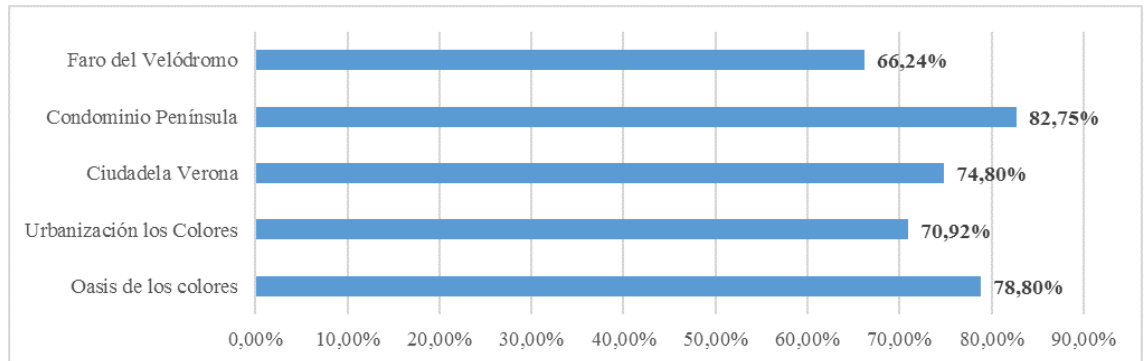
Figure 3. ResidentialSatisfaction Index